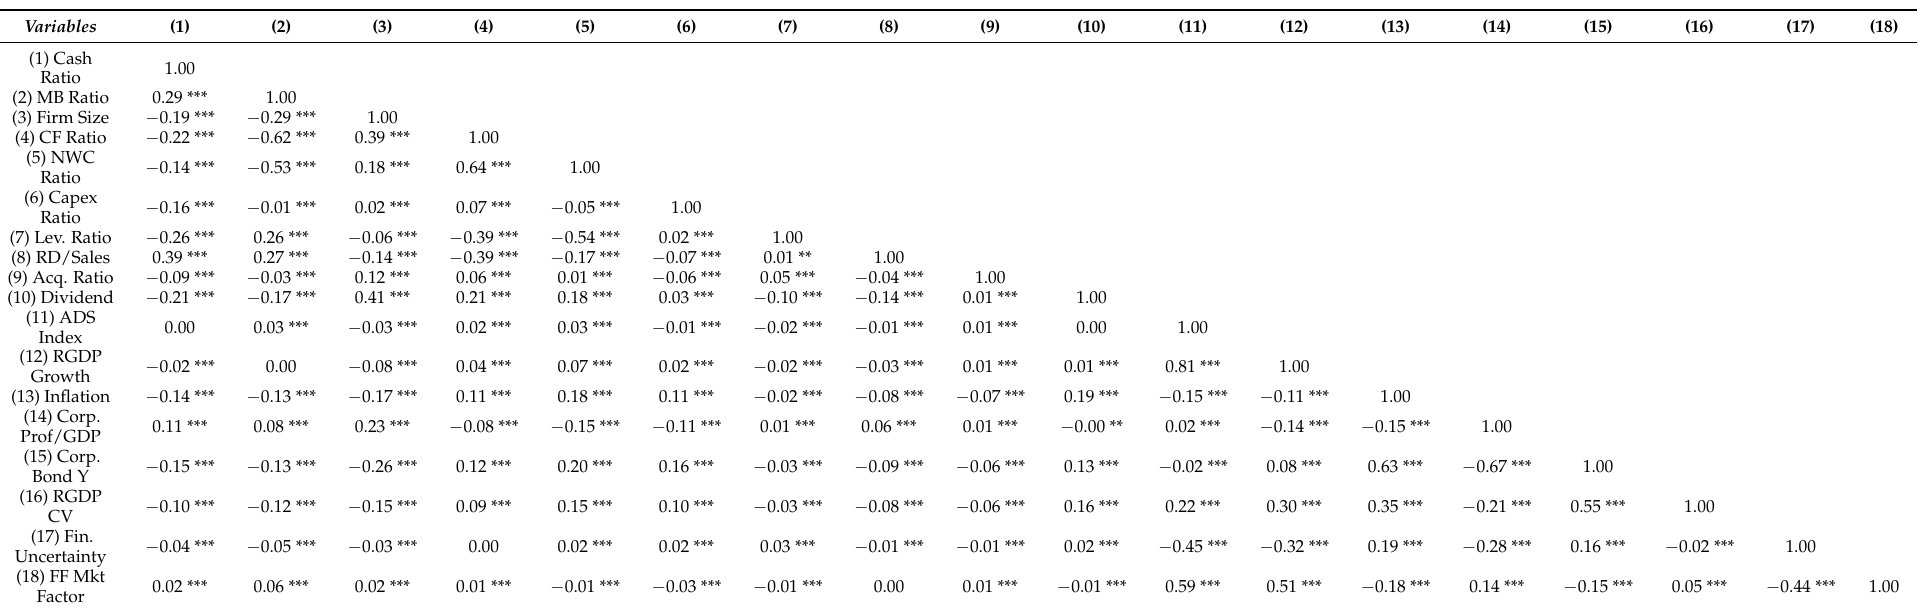
Table 2. Pearson Correlation